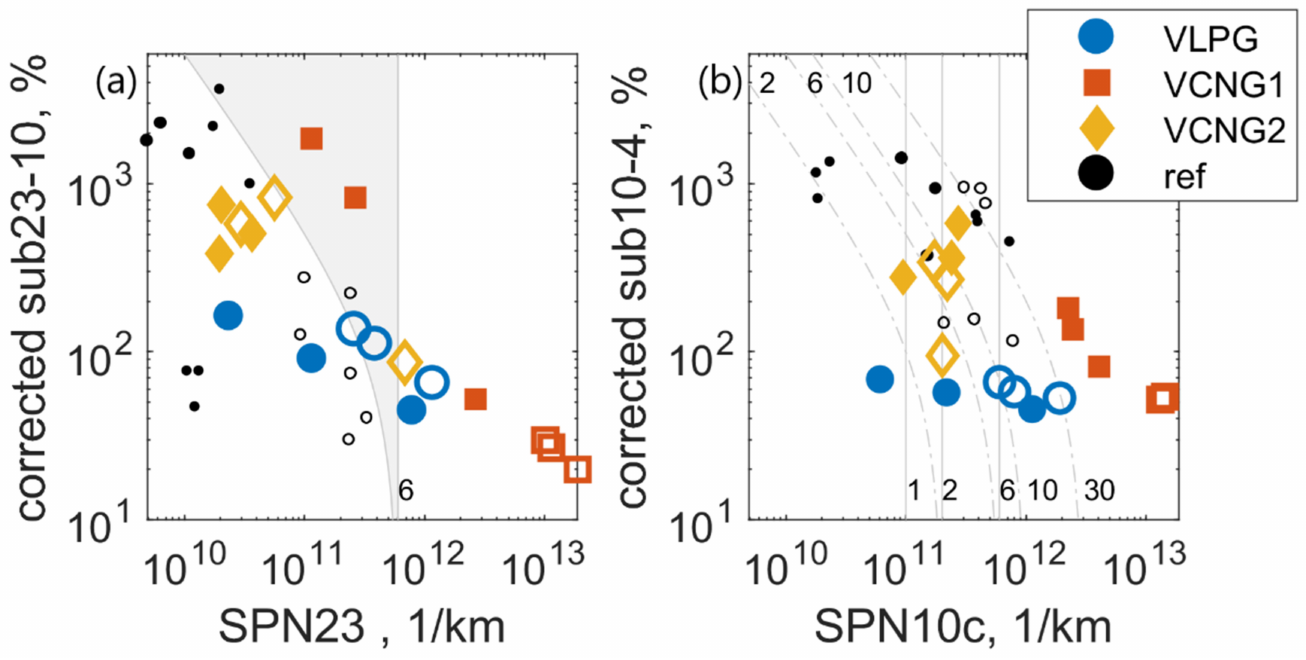
Figure A1. Particle fractions below 23 nm. Data measured with gaseous fuels is presented with filled markers and data for liquid (gasoline) with open markers; ( a ) sub23-10 fraction for corrected SPN10 as a function of SPN23. Shaded area marks data for which SPN10 is above limit 6 × 10 11 1/km, while SPN23 is below the limit; ( b ) sub10-4 fraction for corrected SPN4 and SPN10 as a function of corrected SPN10. Grey vertical lines show SPN10c levels and curved, dash-dotted lines SPN4c levels. Labels 1, 2, 6, 10 and 30 refer to emission level multiples of 10 11 1/km. Data labelled ref is acquired from literature [13] and represents in left axes corrected sub23-10 and in right axes corrected sub10-2.5 levels instead of